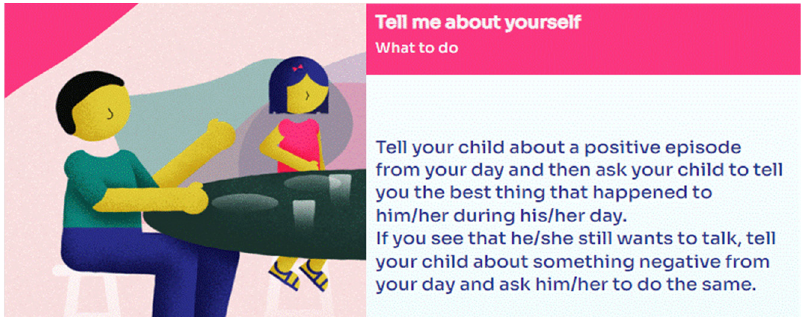
Figure 5. Example of activity within the section “Things to Do” for the experience “Listening with full attention”.